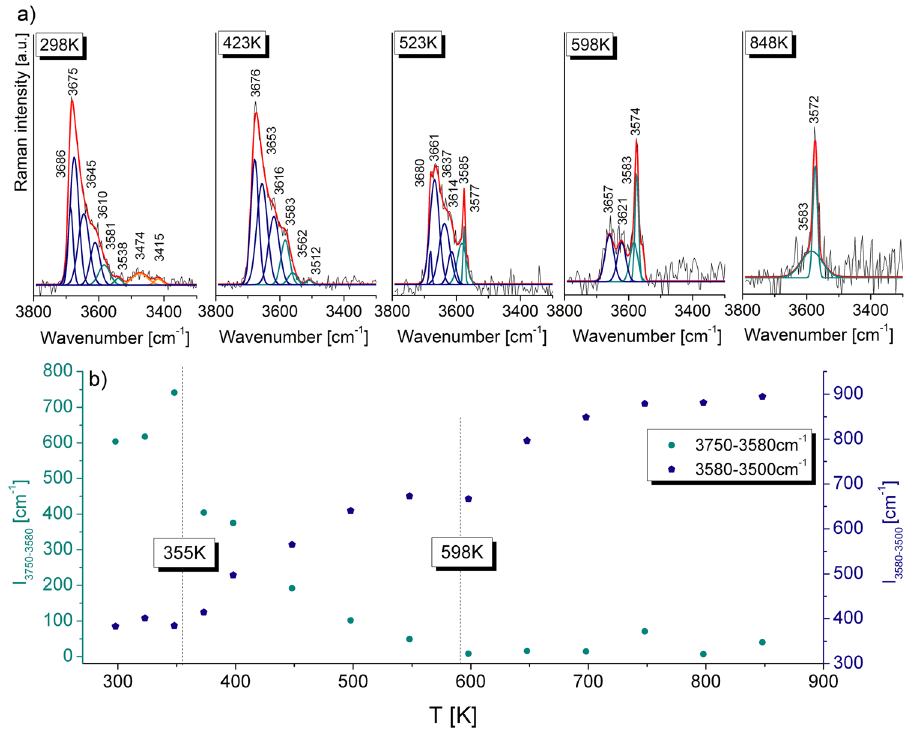
Figure 4. ( a ) The exampled temperature-dependent Raman spectra of chlormayenite in the hydroxyl stretching region. ( b ) The alteration of integral intensity values as a function of temperature in two regions: 3750–3580 cm − 1 and 3580–3500 cm − 1